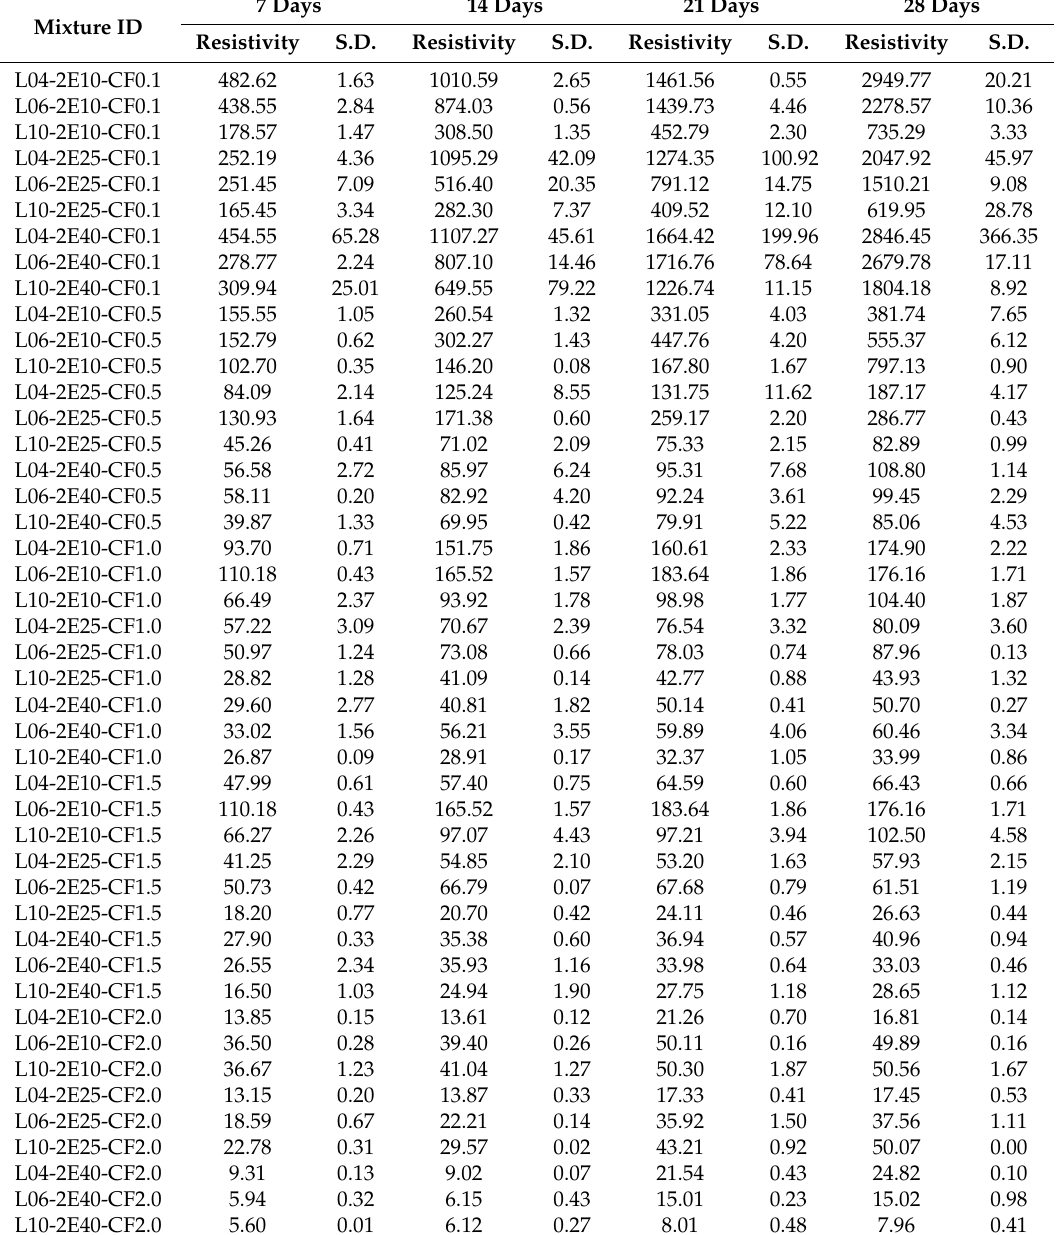
Table 2. Resistivity [Ohm · cm] of cement composites as a function of the curing age for the two-probe configuration; each resistivity is the average of 3 test samples, and S.D. stands for standard